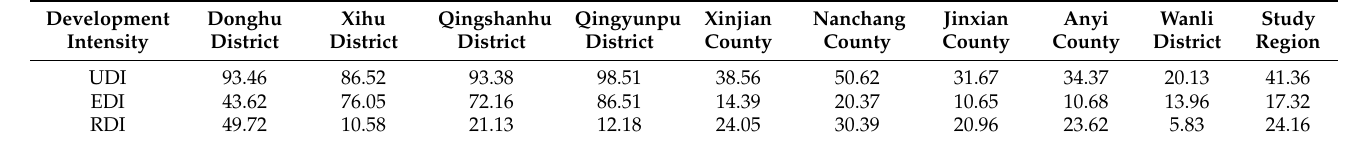
Table 3. Development intensity of urban–rural construction land in the study region (%).